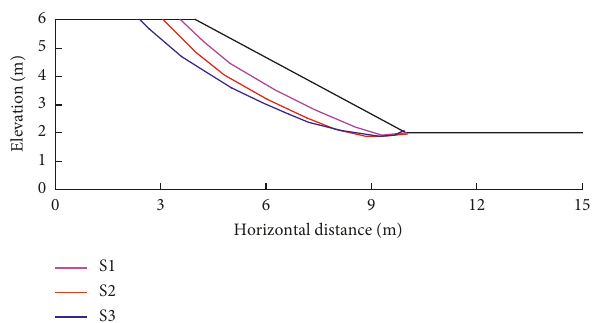
Figure 2: Slope model geometry and observed failure slip surfaces modified after